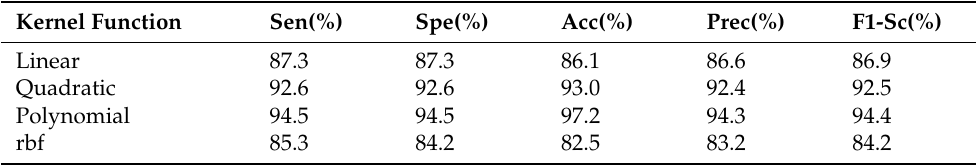
Table 3. Different kernel function of SVM with DWT